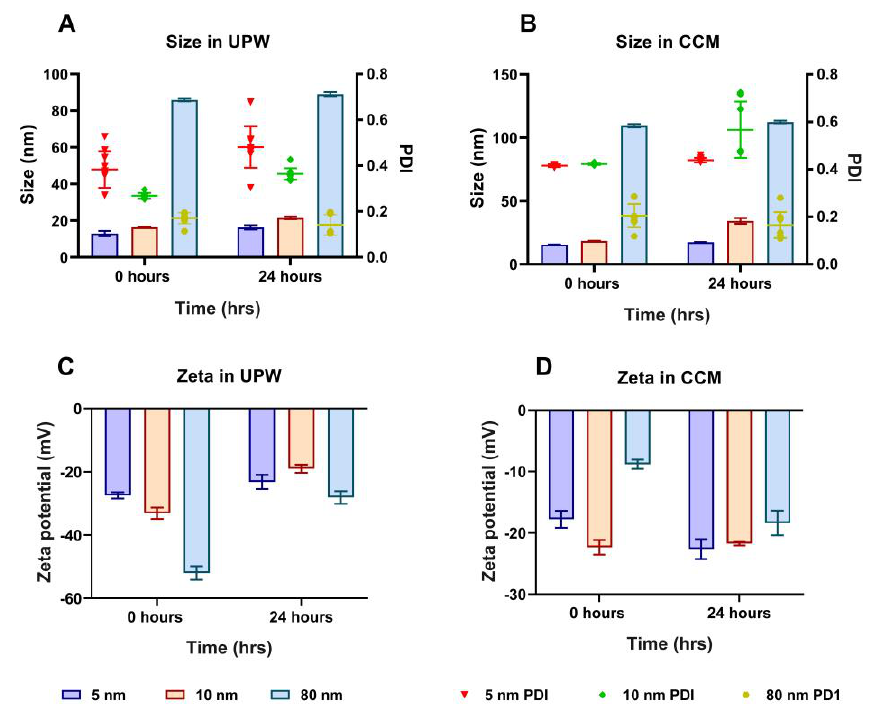
Figure 1. Characterisation of different sizes of AuNPs by DLS in UPW and CCM. Hydrodynamic size distribution and PDI of 5, 10, and 80 nm AuNPs in ( A ) UPW after 0 and 24 h and ( B ) CCM after 0 and 24 h. Zeta potential values of 5, 10, and 80 nm AuNPs in ( C ) UPW after 0 and 24 h and ( D ) CCM after 0 and 24 h. Plotted graphs represent the means ± standard deviation (SD) of 10 different measurements.